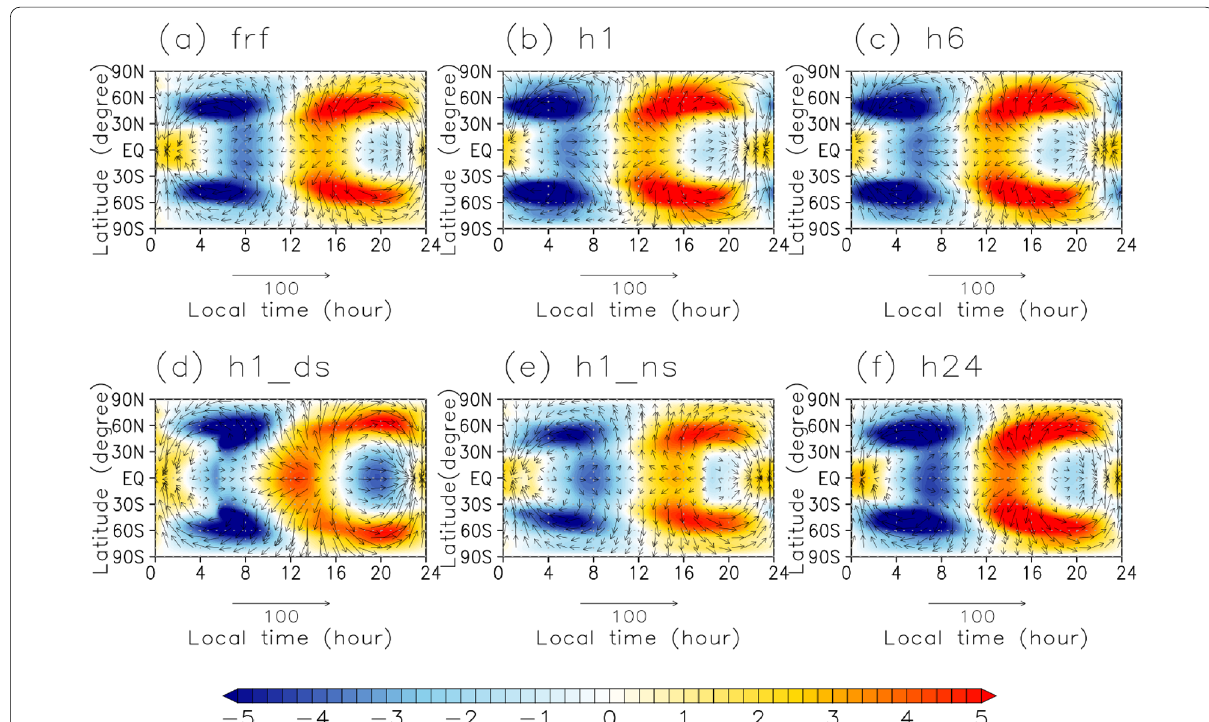
Fig. 2 Horizontal distributions of horizontal wind (vector, m s − 1 ) and temperature deviations (color, K) associated with the thermal tides at the cloud top level (~ 70 km). The cases of a frf, b h1, c h6, d h1_ds, e h1_ns, and f h24 are shown. These distributions are calculated by the composite means over 30 Earth days at the sub-solar point (fixed at the center of each